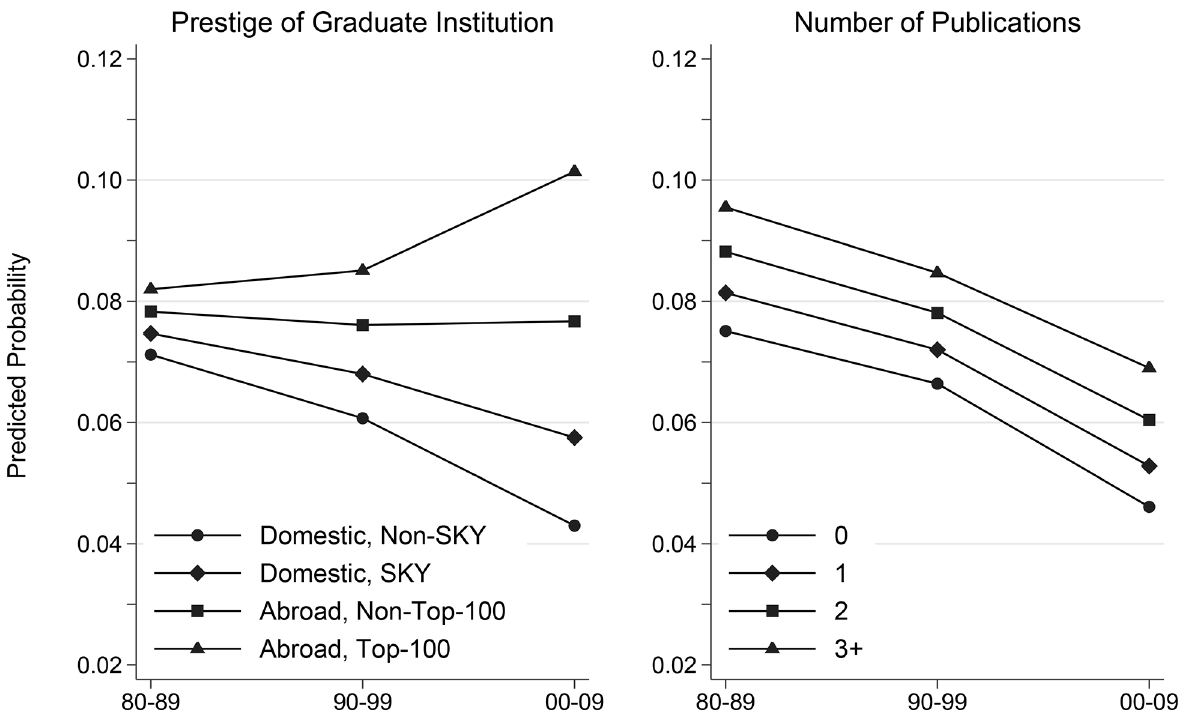
Fig 3. Predicted Probability of Getting a First Tenure-Track Academic Position, by Prestige of Graduate Institution, Number of Publications, and Doctoral Cohort: Korea Researcher Information (KRI) Database, 1980 – 2009.